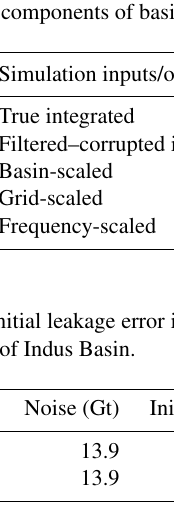
Table 7. Time series components of basin averages from the simulation using integrated WGHM.